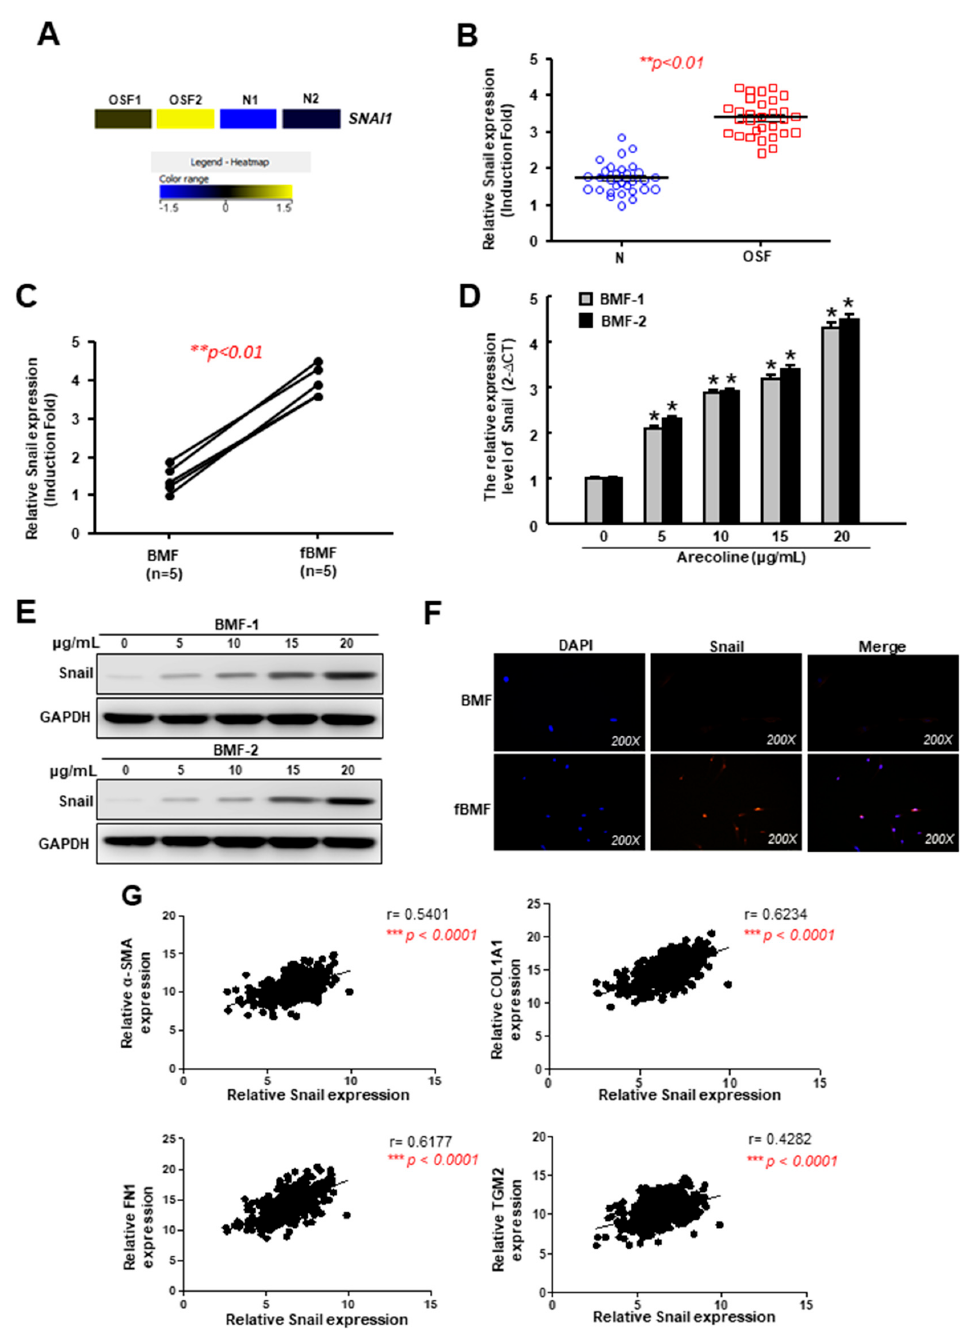
Figure 1. The expression of Snail is upregulated in oral submucosal fibrosis (OSF) tissues owing to arecoline stimulation. ( A ) A heat-map showing the upregulation of Snail in OSF ( n = 2) and normal ( n = 2) buccal mucosal tissues using RNA-sequencing; ( B ) The relative expression of Snail in normal and OSF specimens ( n = 30); ( C ) The relative expression of Snail in normal human buccal mucosal